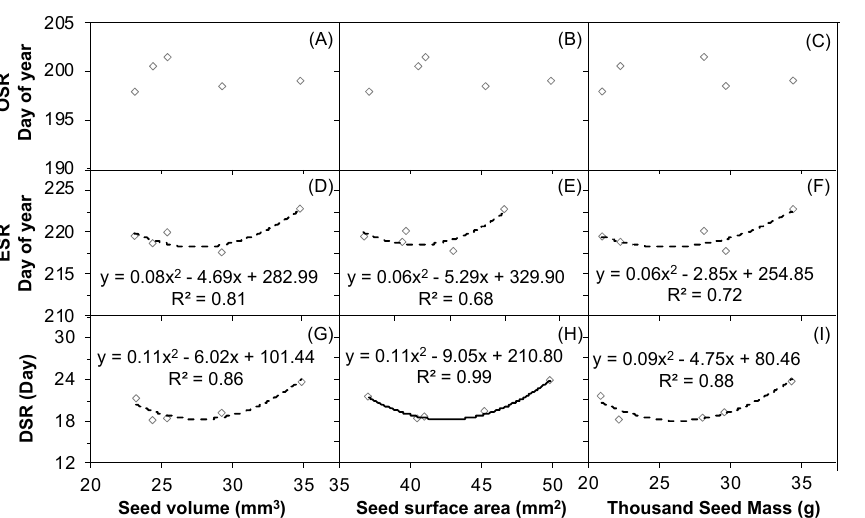
Figure 8. Correlations of the seed release (OSR), (ESR) and (DSR) with seed volume ( A , D , G ), seed surface area ( B , E , H ), and the Thousand Seed Mass ( C , F , I ) of Nitraria tangutorum in 2017. The solid line indicates p ≤ 0.05, and the dashed lines indicate p > 0.05. The seed volume, surface area, and the Thousand Seed Mass data were derived from a study by Zhang et al., 2019 [48].